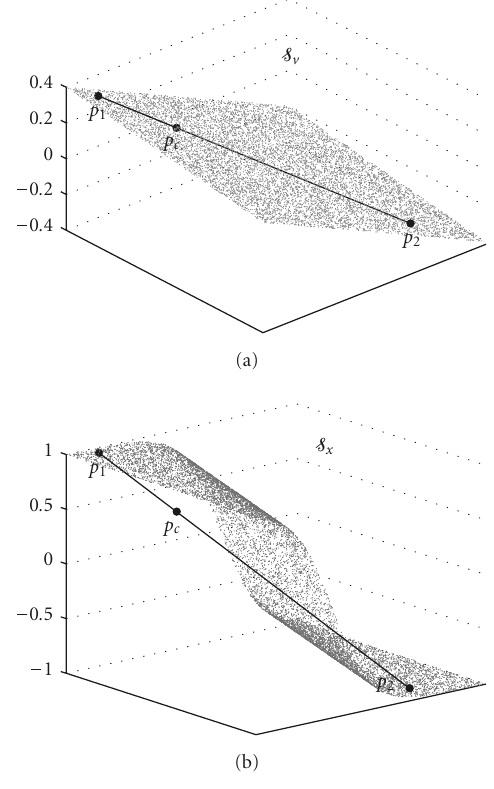
Figure 5: An example showing the di ff erence between a plane and a nonlinear surface. (a) A plane: arbitrary point p c ∈ p 1 p 2 lies on S v . (b) A nonlinear surface: the point p c